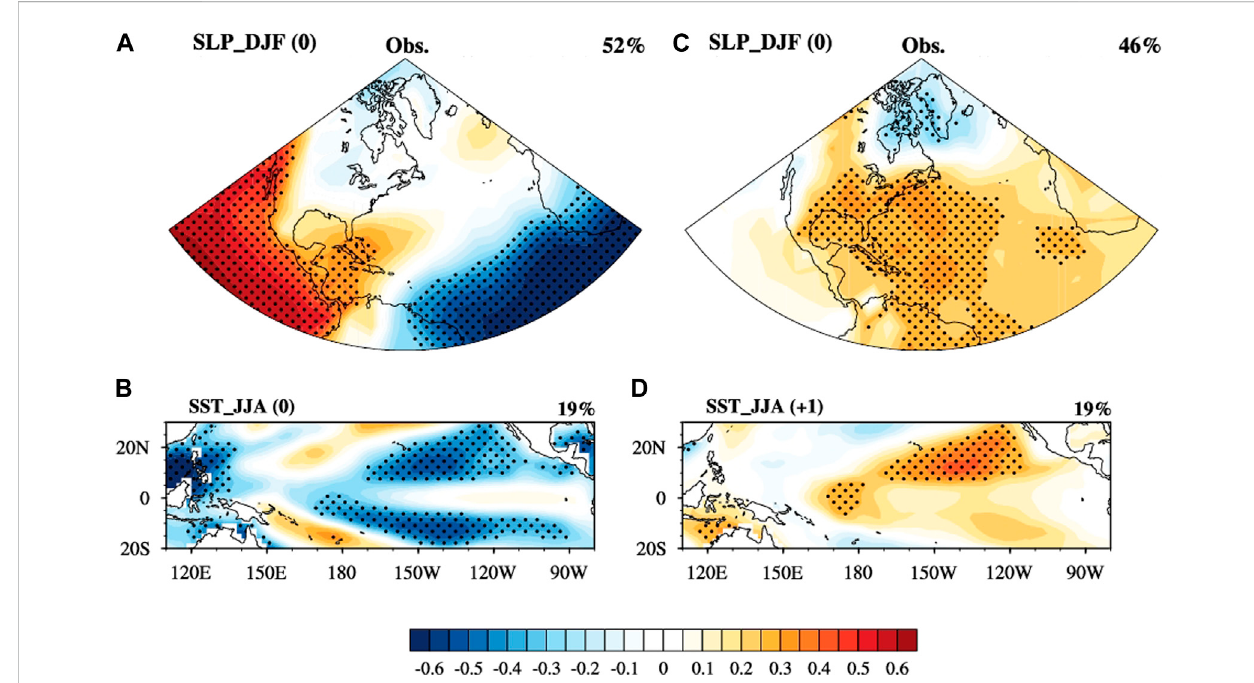
FIGURE 2 Heterogeneous correlation maps of the leading SVD mode of the DJF-mean SLP anomalies in North America and the North Atlantic [110 ° W – 0, 20 ° N – 90 ° N] and the following JJA-mean SST anomalies in the tropical Paci fi c [170 ° E – 60 ° W, 10 ° S – 30 ° N] in the same year (A,B) and lagged 1 year (C,D) . Stippled regions indicate above the 90% signi fi cance level based on the Student ’ s